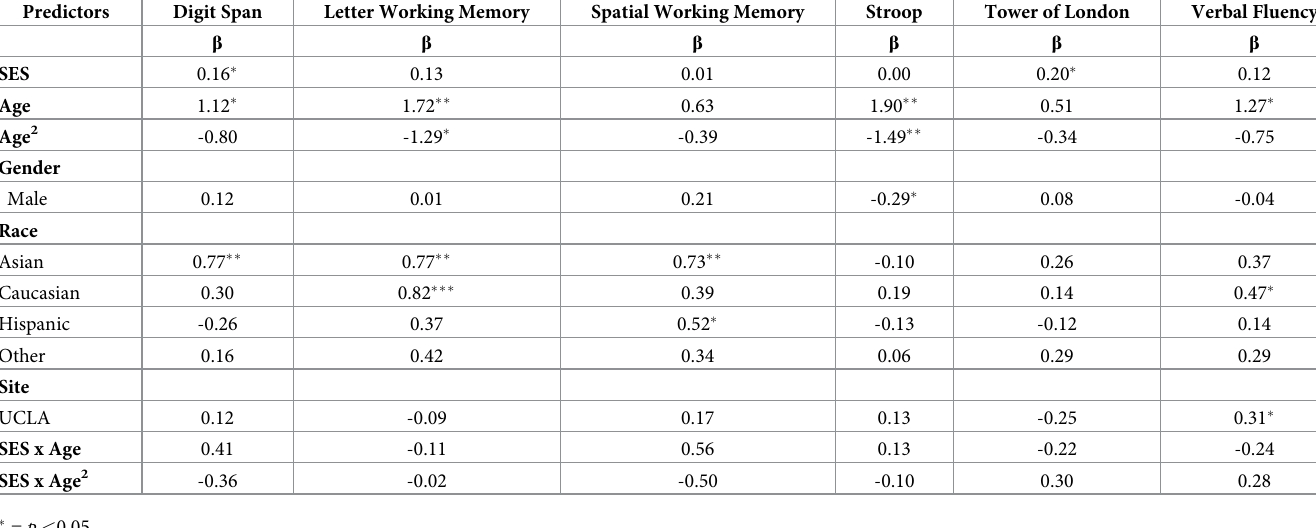
Table 10. Multiple regression analyses of EF measures on SES with interaction terms, covarying for race ( N =